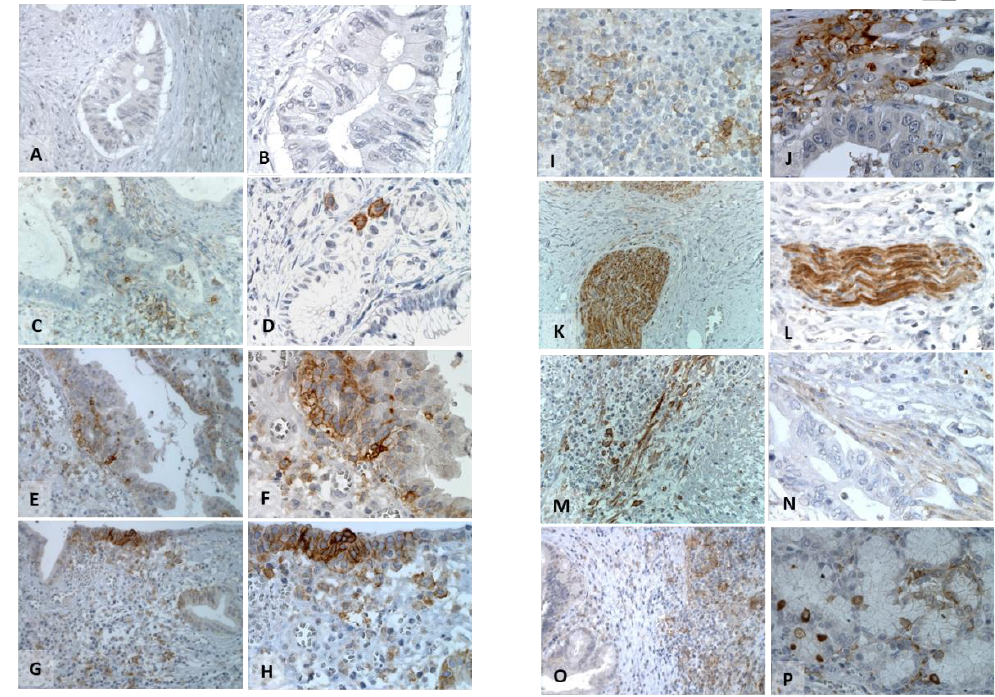
Figure 4. PDL-1 is predominantly expressed by TME in PDACs. Representative expression in PDAC (left panel 200 × and 400 × magnification). PD-L1-negative sample ( A , B ). PD-L1 low expression, featured by membrane staining with low diffusion ( C , D ). PD-L1 moderate expression, featured by heterogeneous diffusion of membrane staining ( E , F ). PD-L1 high expression, featured by diffused and strong membrane staining in PDAC ( G , H ). TME analysis (right panel): Representative PD-L1-positive staining in lymphocytes and histiocytes surrounding PDACs ( I , J ). Intense homogeneous and consistent PD-L1 expression in nerves ( K , L ) (200 × and 400 × magnification) as a major source of PD-L1 in PDAC. PD-L1 was further reported in fibrotic tissue ( M , N ) (200 × and 400 × magnification) and in peritumoral lympho-monocytic infiltrating cells ( O , P ). Table 3. CXCR4, CXCR7, CXCL12 and PD-L1 association with patient clinicopathological